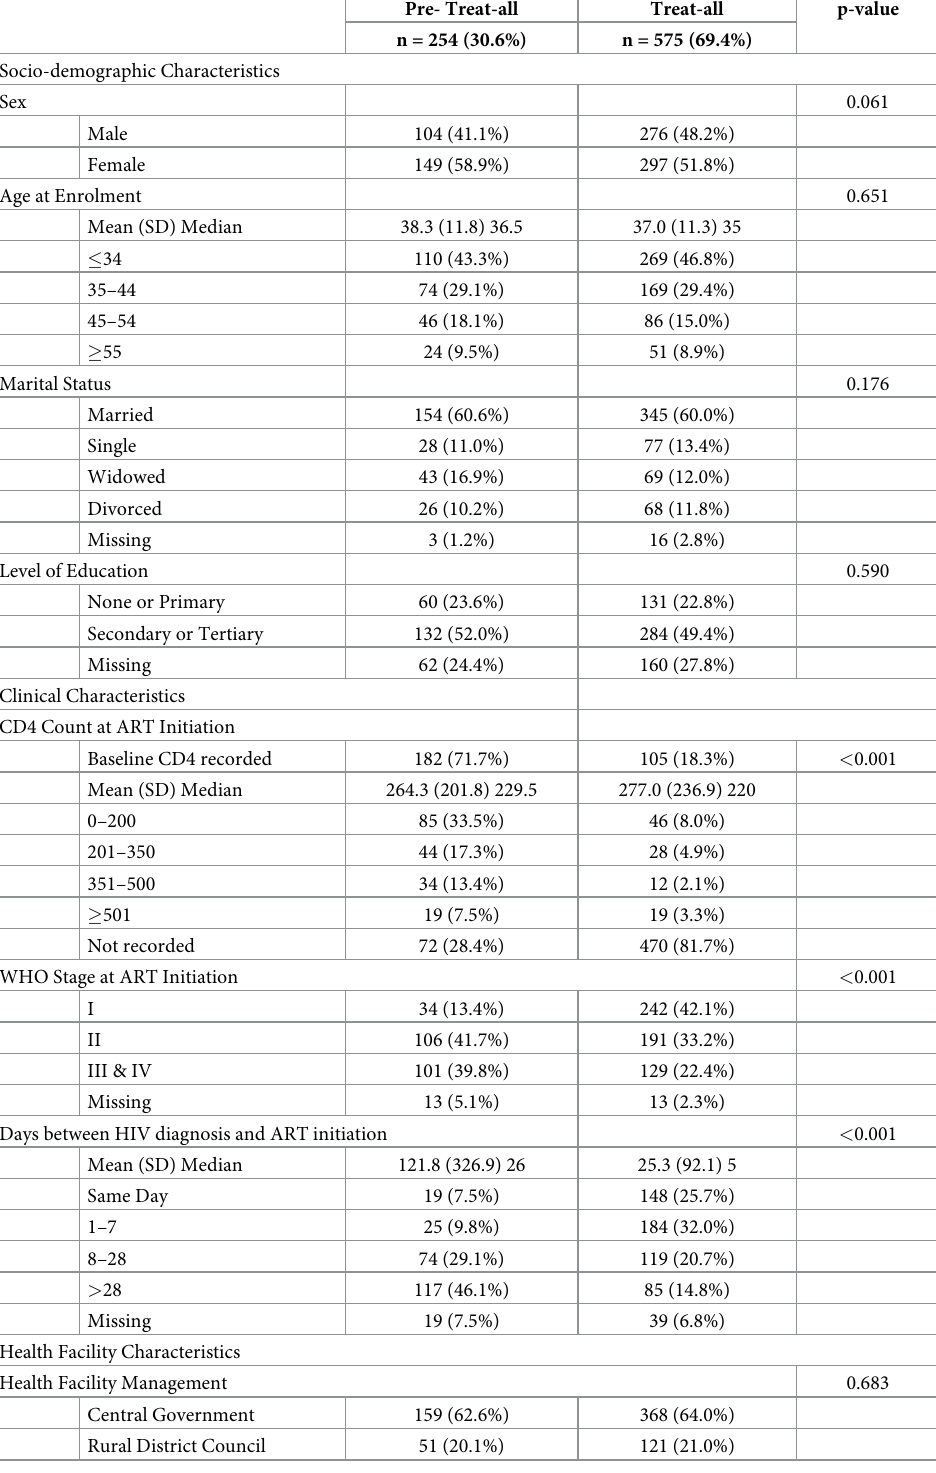
Table 1. Baseline characteristics of the ART patient populations in the pre- treat-all and treat-all periods, Manica- land, Zimbabwe, July 2015 to June 2017. Pre- Treat-all Treat-all p-value n = 254 (30.6%) n = 575